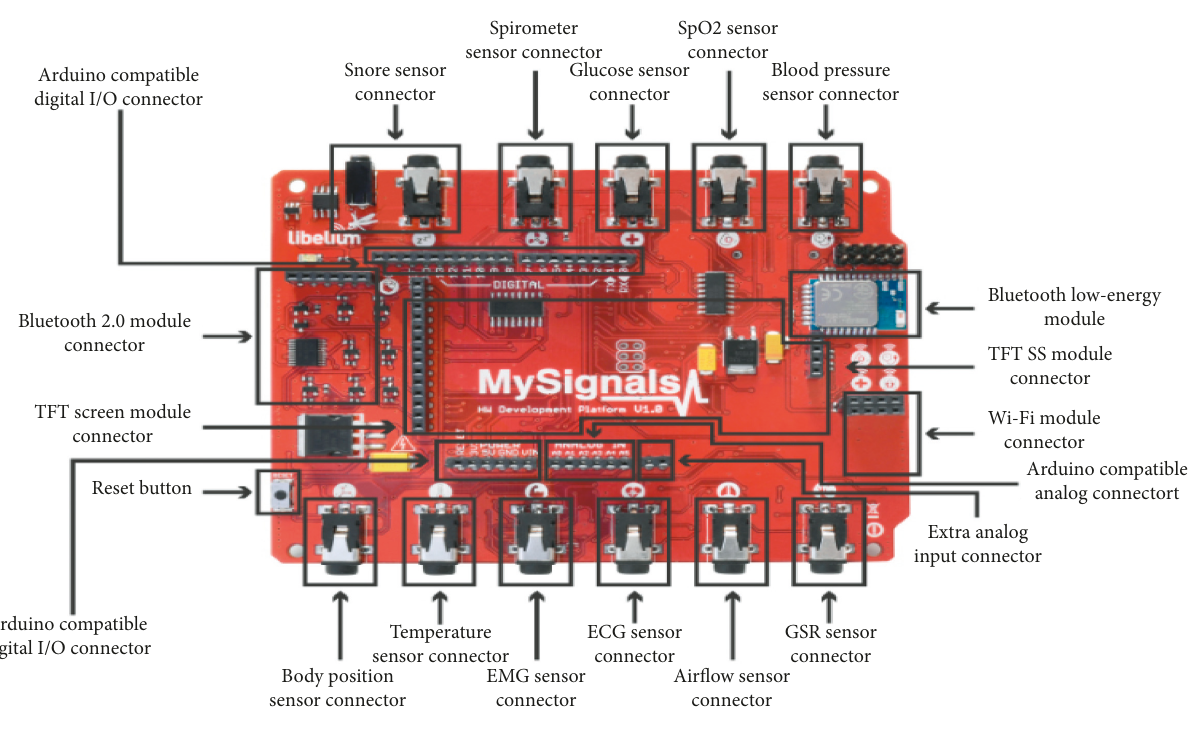
Figure 1: eHealth sensor board (source: MySignals website (http://www.my-signals.com/)).